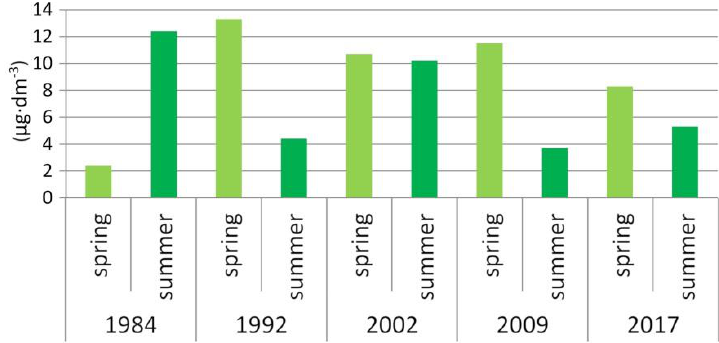
Figure 9. Changes in chlorophyll a concentrations (µg·dm −3 ) in Lake Borówno from 1984 to 2017